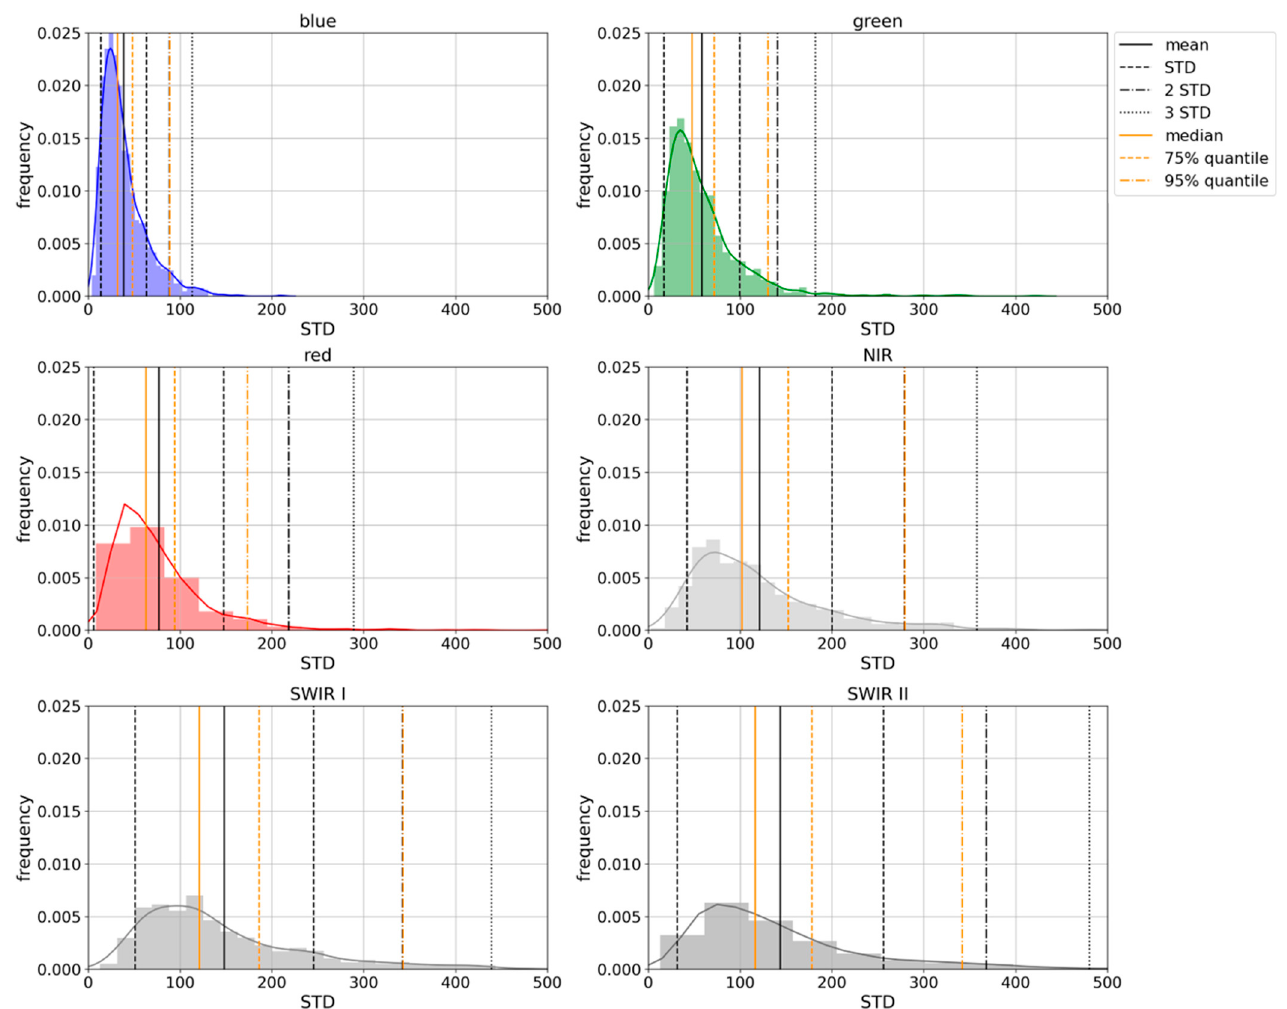
Figure 5. Frequency distribution of the STDs of all pixel clusters per band. Twice, the STD per band was selected as the threshold for the identification of deviating pixel clusters.